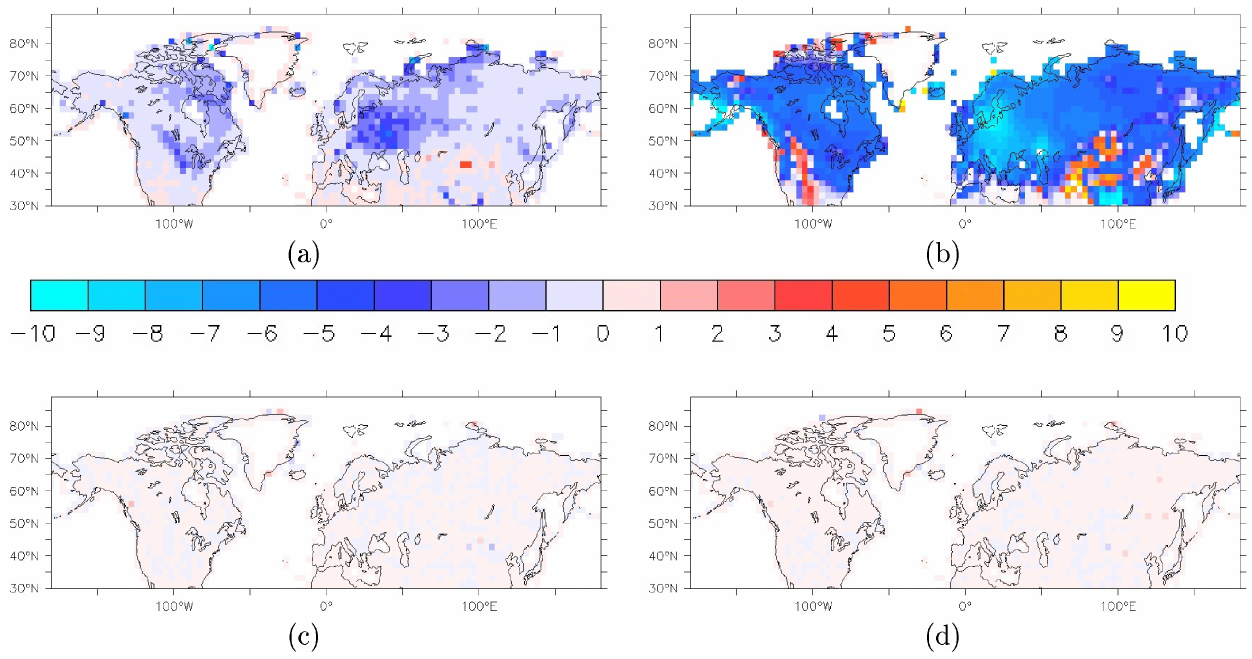
Fig. 3. Mean number of days per year with snow at the surface (MNDWS); (a) present-day MNDWS difference induced by BC deposition on snow; S1–S1B. (b) MNDWS difference between 2050 climate with RCP8.5 emission scenario and present-day simulation (S2 N–S1); (c) MNDWS difference between a 2050 scenario with higher ship traffic in the Arctic in comparison with 2050 RCP8.5 scenario (S3 N– S2 N); (d) MNDWS difference between a 2050 scenario with increased biomass burning activity in comparison with 2050 RCP8.5 scenario (S4 N–S2 N). Note that future simulations are nudged toward the S2 N future simulation. The differences shown in (a) and (b) are statisti- cally significant according to a two-sample t test over the whole